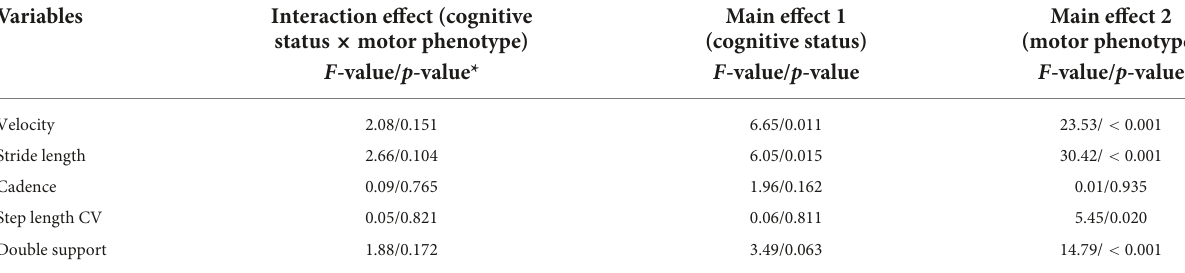
TABLE 2 Differences in gait parameters in relation to cognitive status and motor